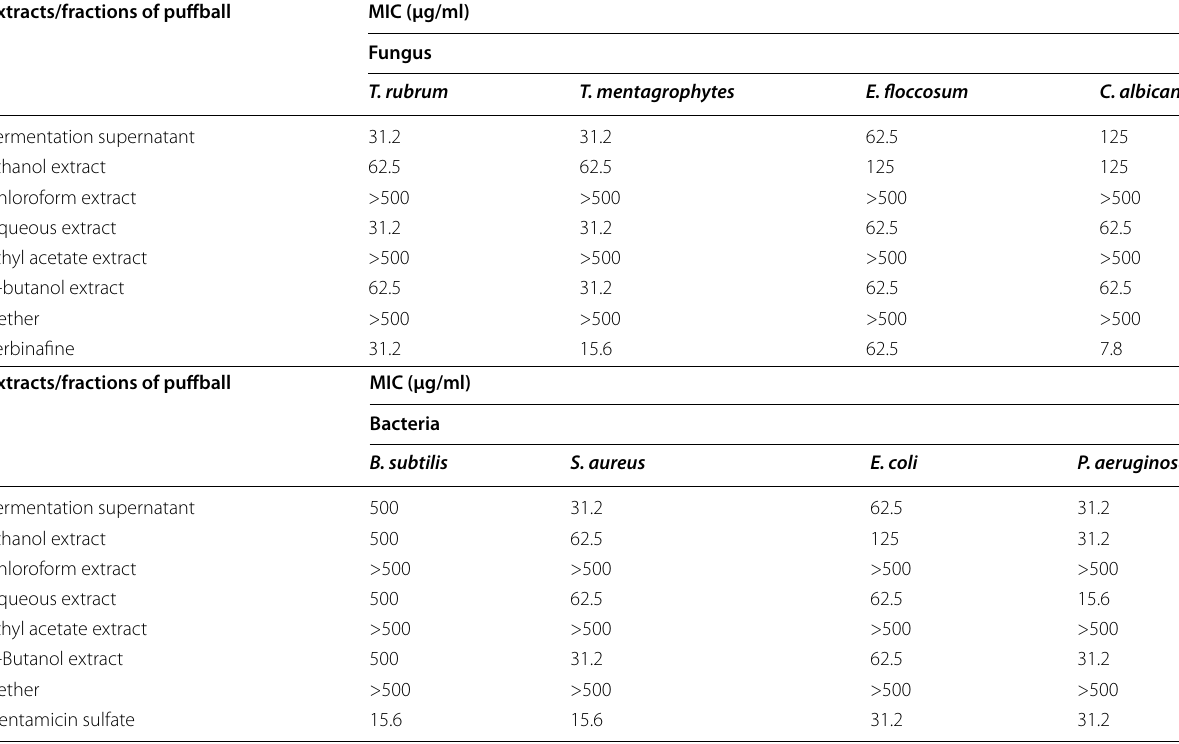
Table 1 MIC values of fermentation supernatant and extracts of puffball Extracts/fractions of